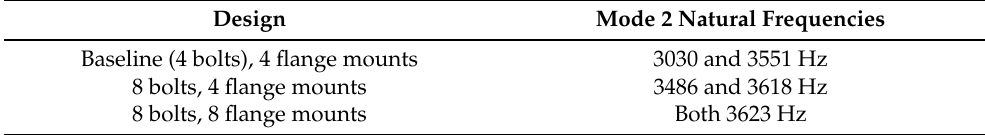
Table 8. Mode 2 natural frequencies of an additional flange mount design.